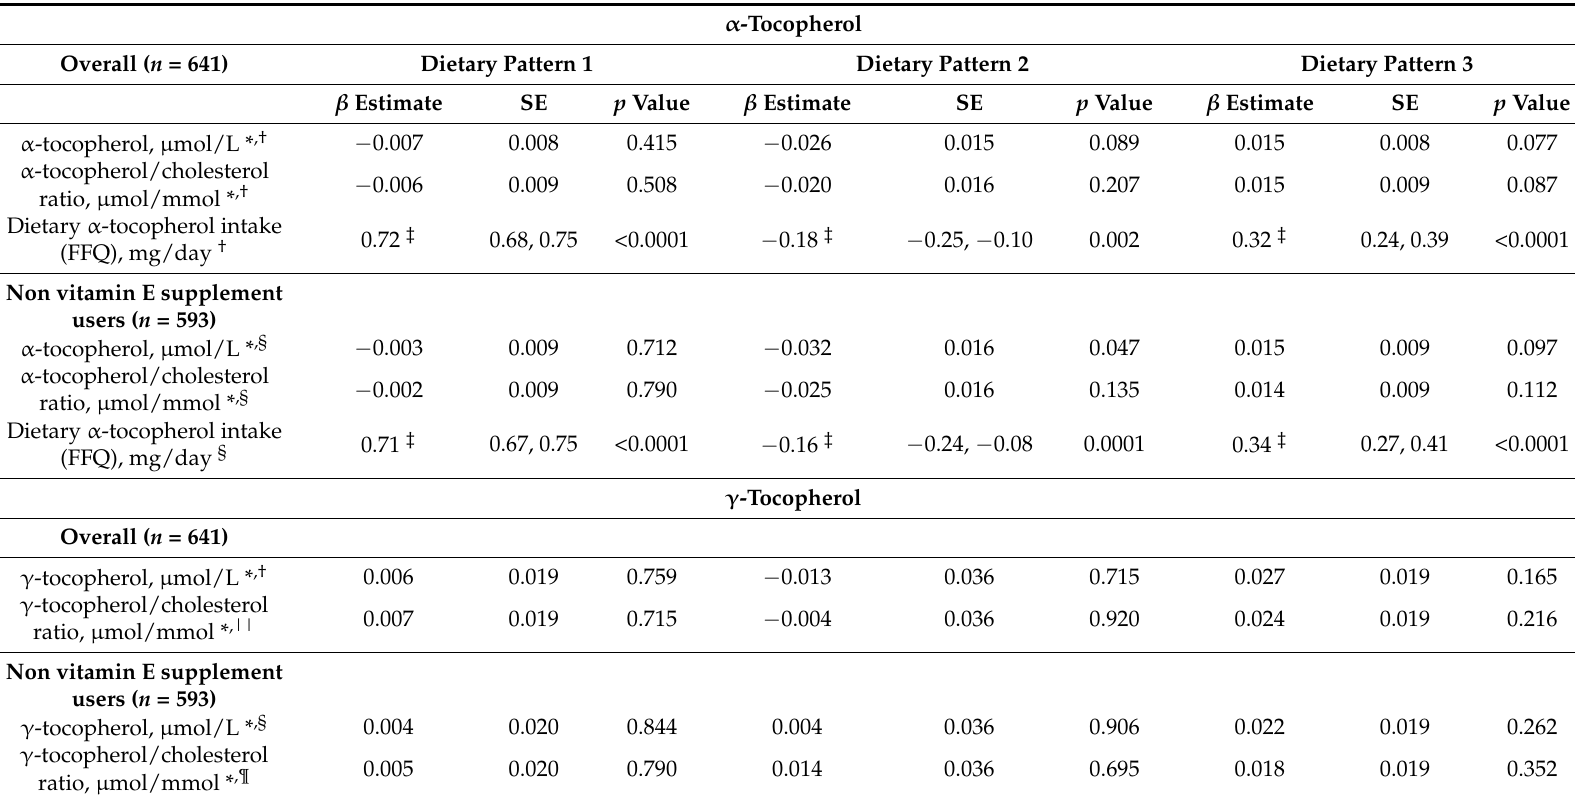
Table 4. Multivariable-adjusted linear regression models for the association between a Principal Component Analysis (PCA)-derived dietary patterns with plasma α - and γ -tocopherol levels and dietary α -tocopherol